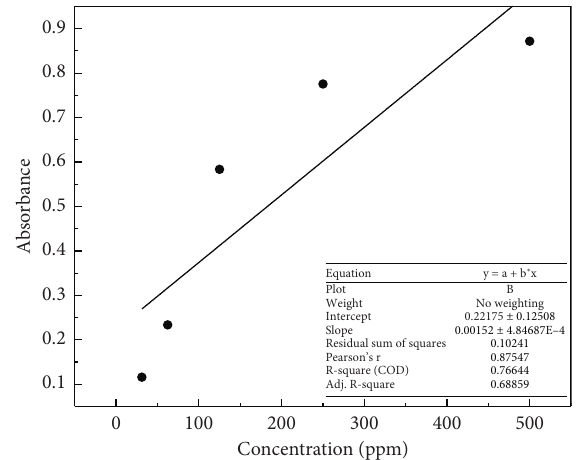
Figure 11: Calibration curve (linear fitting) for the determination of ferrous ions.